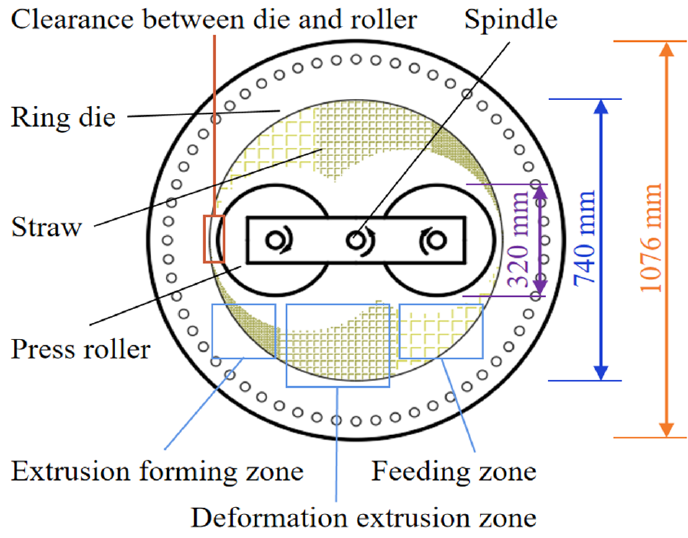
Figure 2. Schematic diagram of the distribution of straw inside the briquetting